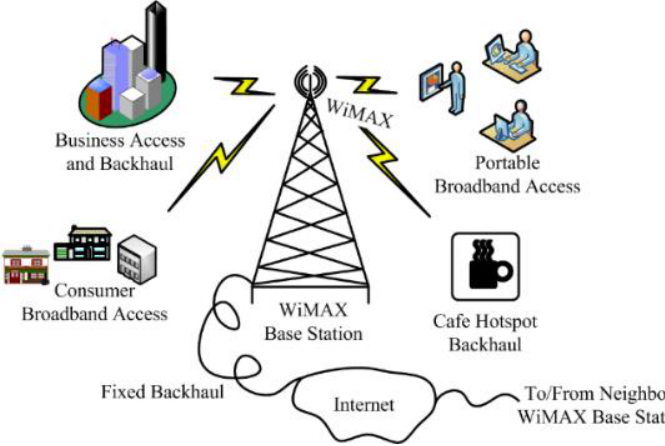
Figure 25. WiMAX top-level architecture.